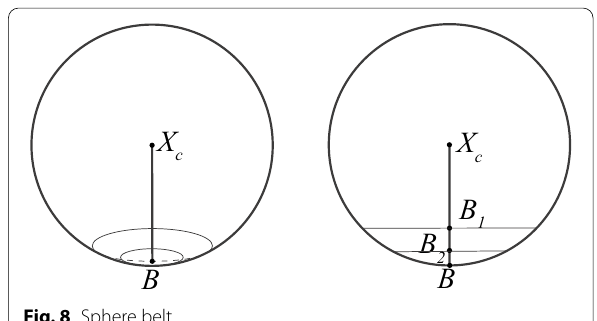
Fig. 8 Sphere belt